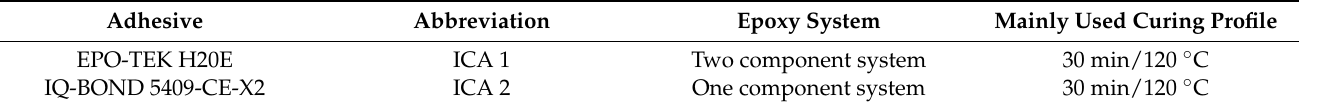
Table 2. Overview of used ICA.